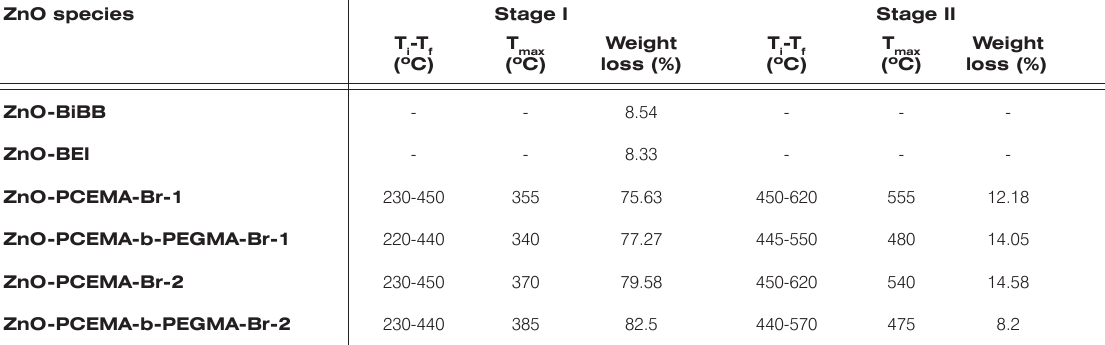
Table 2. The TGA analysis data of the ZnO derivatives and the corresponding polymers.